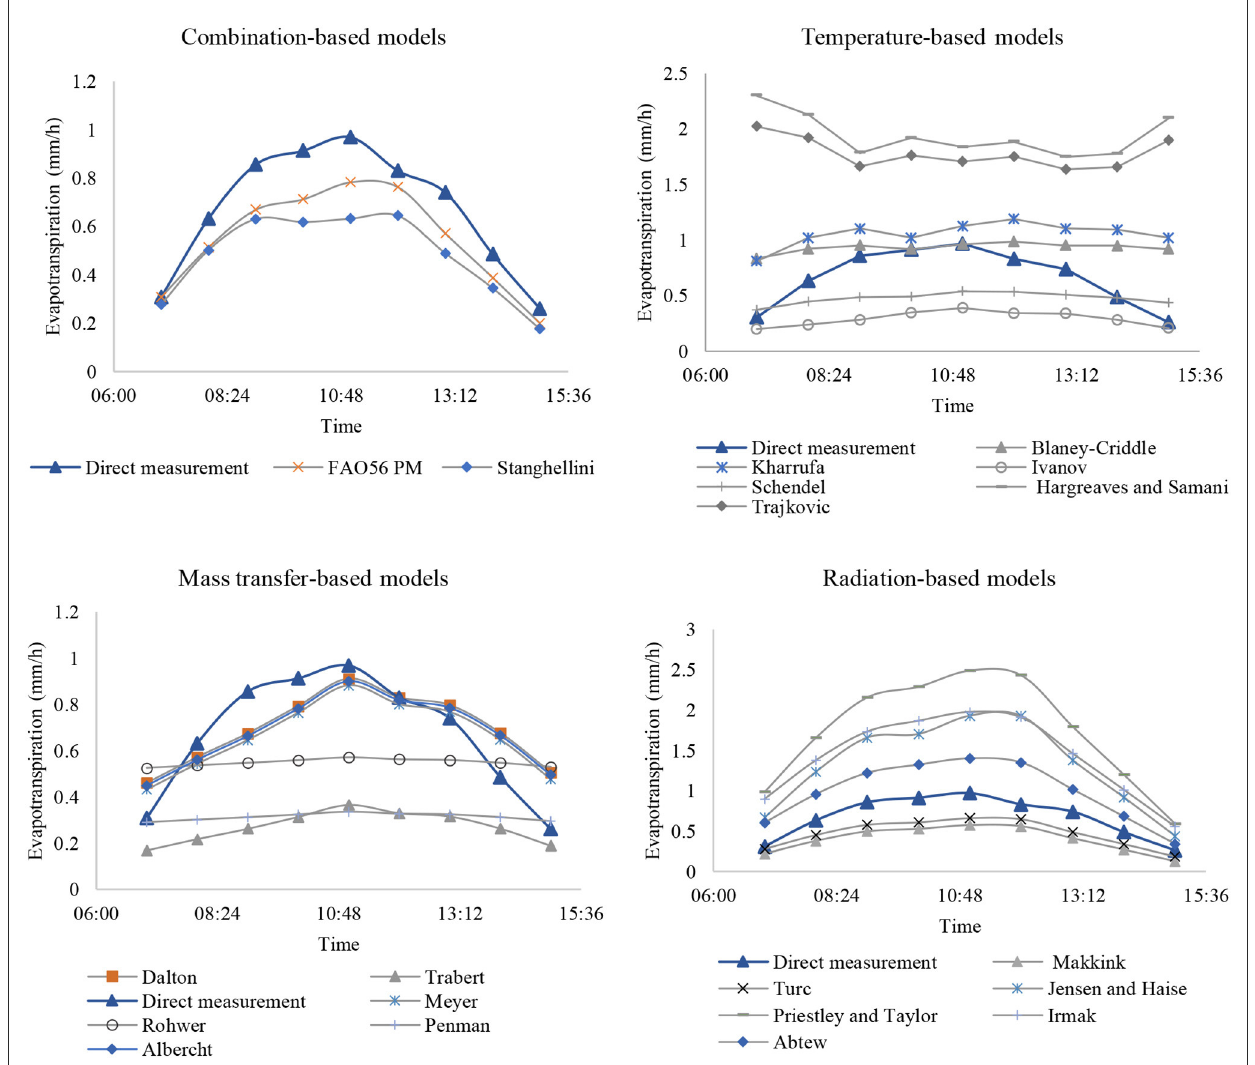
FIGURE4 Hourly evapotranspiration evaluated from various ET 0 models and transpiration from direct gas exchange measurement.